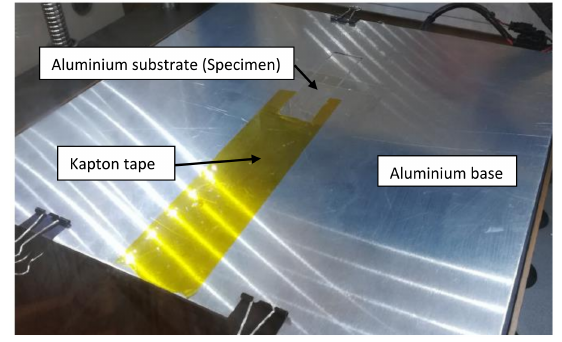
Figure 2. 3D printer customized